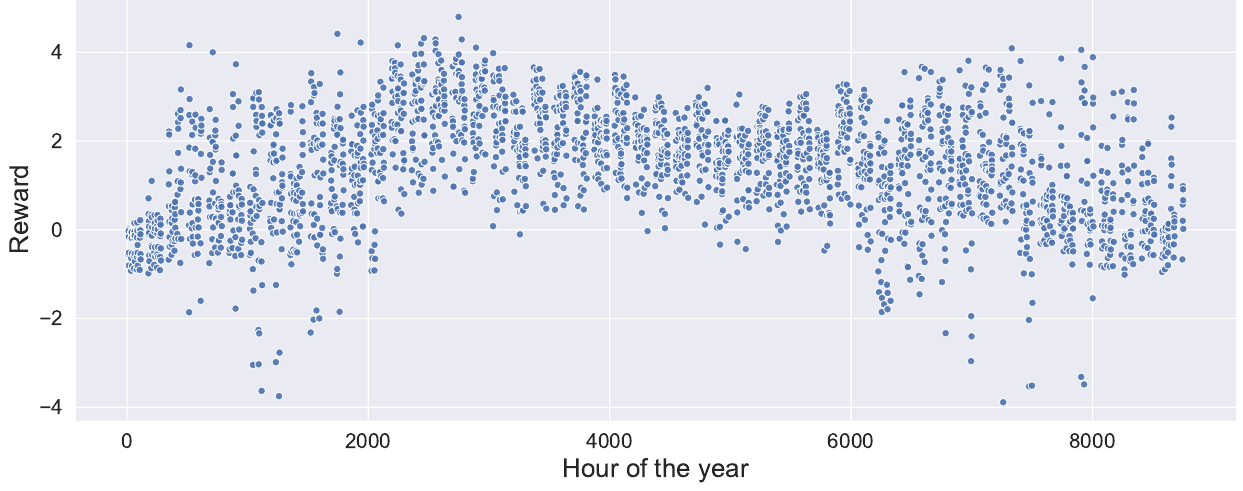
Figure 19. Rewards achieved by the DQN agent at different time steps over the course of